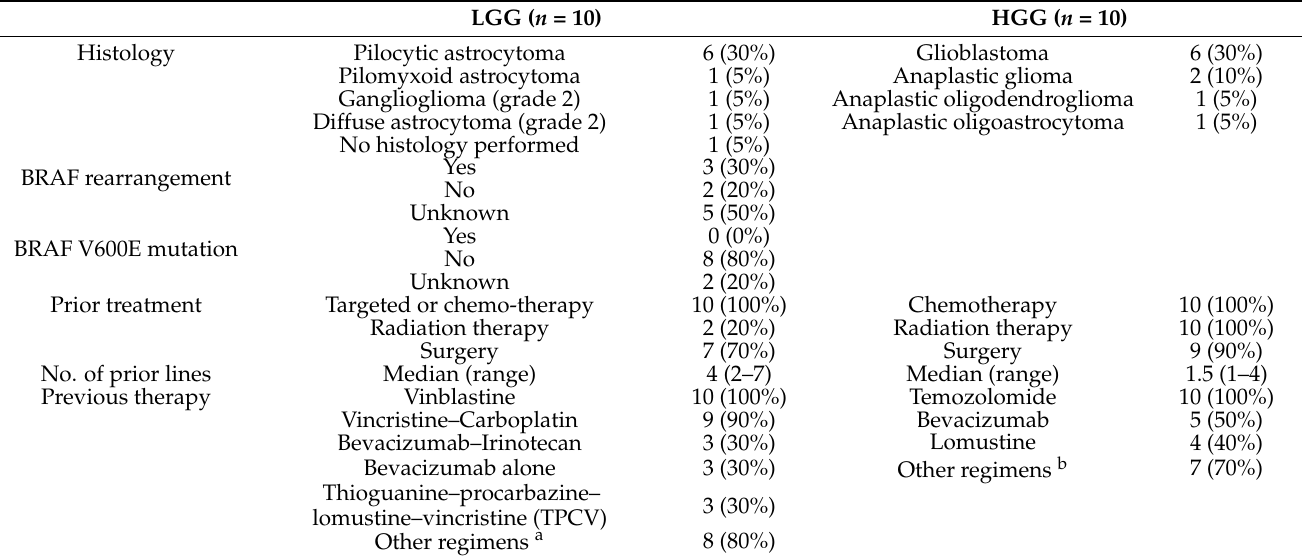
Table 2. Tumor and treatment characteristics per tumor grade (LGG and